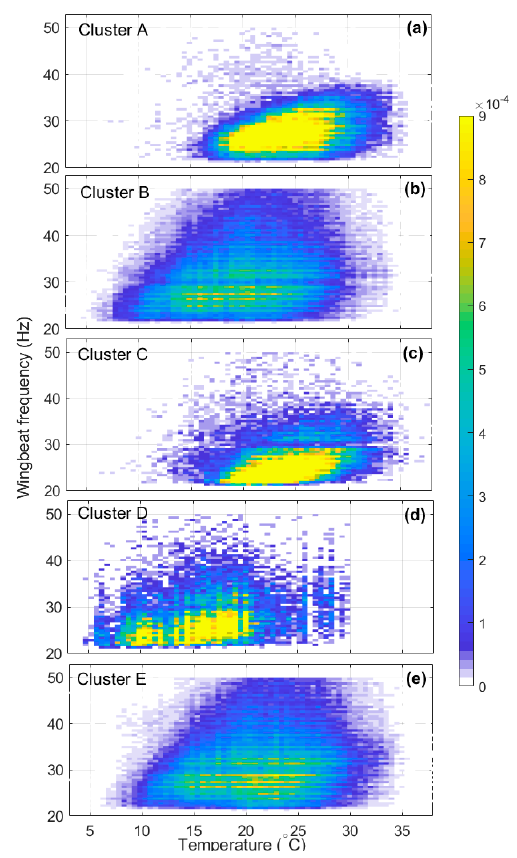
Figure 5. The relationship between wingbeat frequency and temperature for insects in ( a – e ) clusters A to E. Other plot conventions as in Figure 2. Table 3. Means and standard deviations of wingbeat frequency ( f w ) and air temperature ( T ) for each cluster and coefficient of linear regression of the f w on T for each cluster.